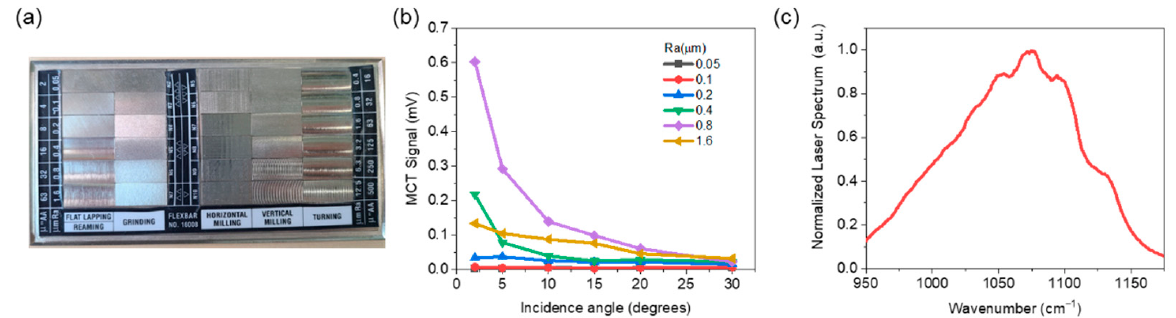
Figure 2. ( a ) Photograph image of the roughness standard nickel plates. ( b ) Backscattering signal measured by the MCT when the QCL light at a wavenumber of 1090 cm − 1 is irradiated onto the reflective substrates with different surface roughnesses at different incidence angles. ( c ) Normalized QCL power spectra averaged over all measured values using reflective substrate with different surface roughness and different incidence angle.